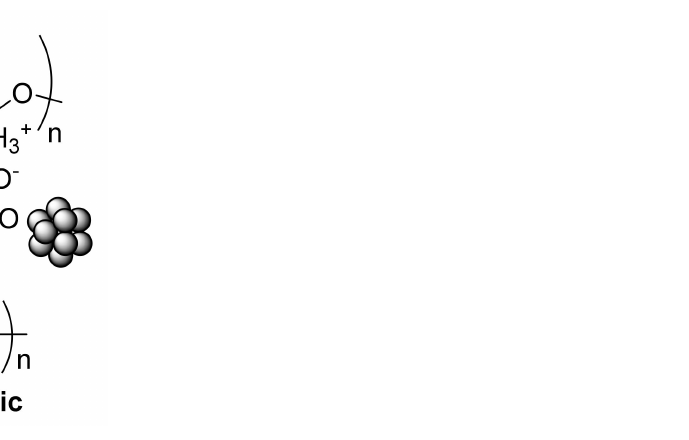
Figure 2. Schematic representation of anchoring sites for metal oxide nanoparticles